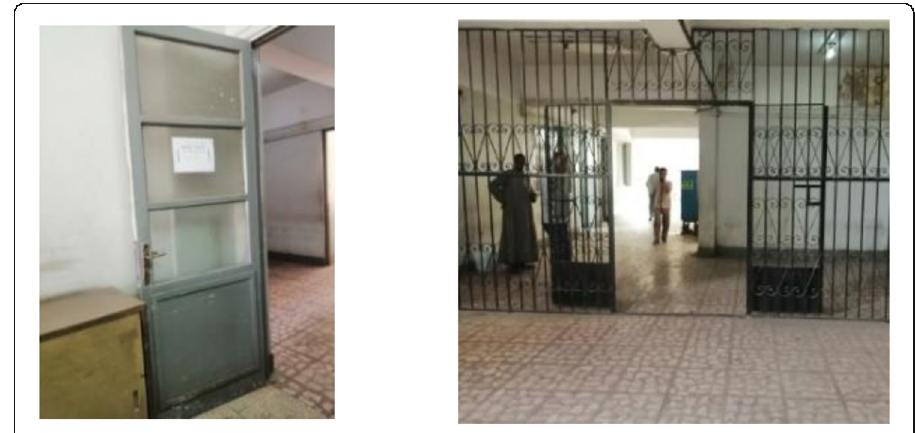
Fig. 7 Different types of interior doors,